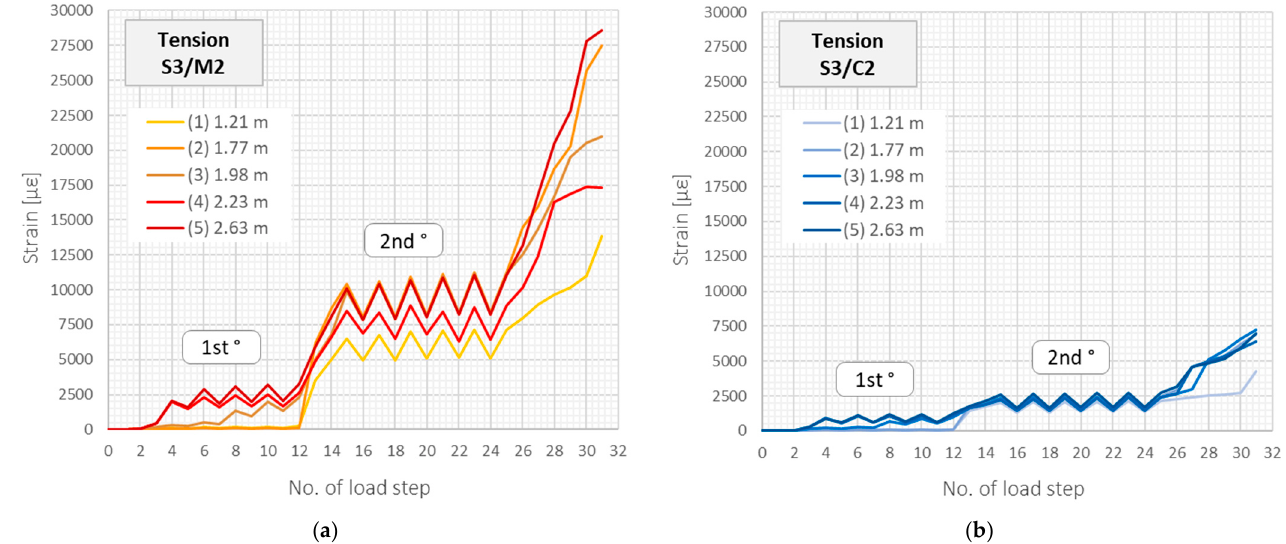
Figure 13. Beam S3/tension zone: strain profiles registered by ( a ) monolithic sensor M2 and ( b ) lay- ered sensing cable C2 with steel strengthening insert.